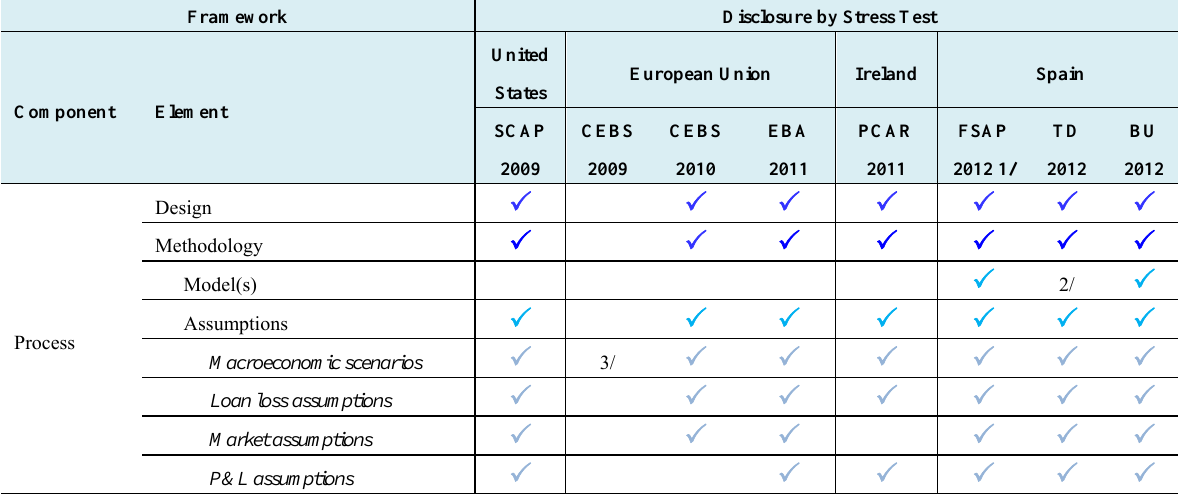
Table 9. Crisis Stress Tests: Disclosure